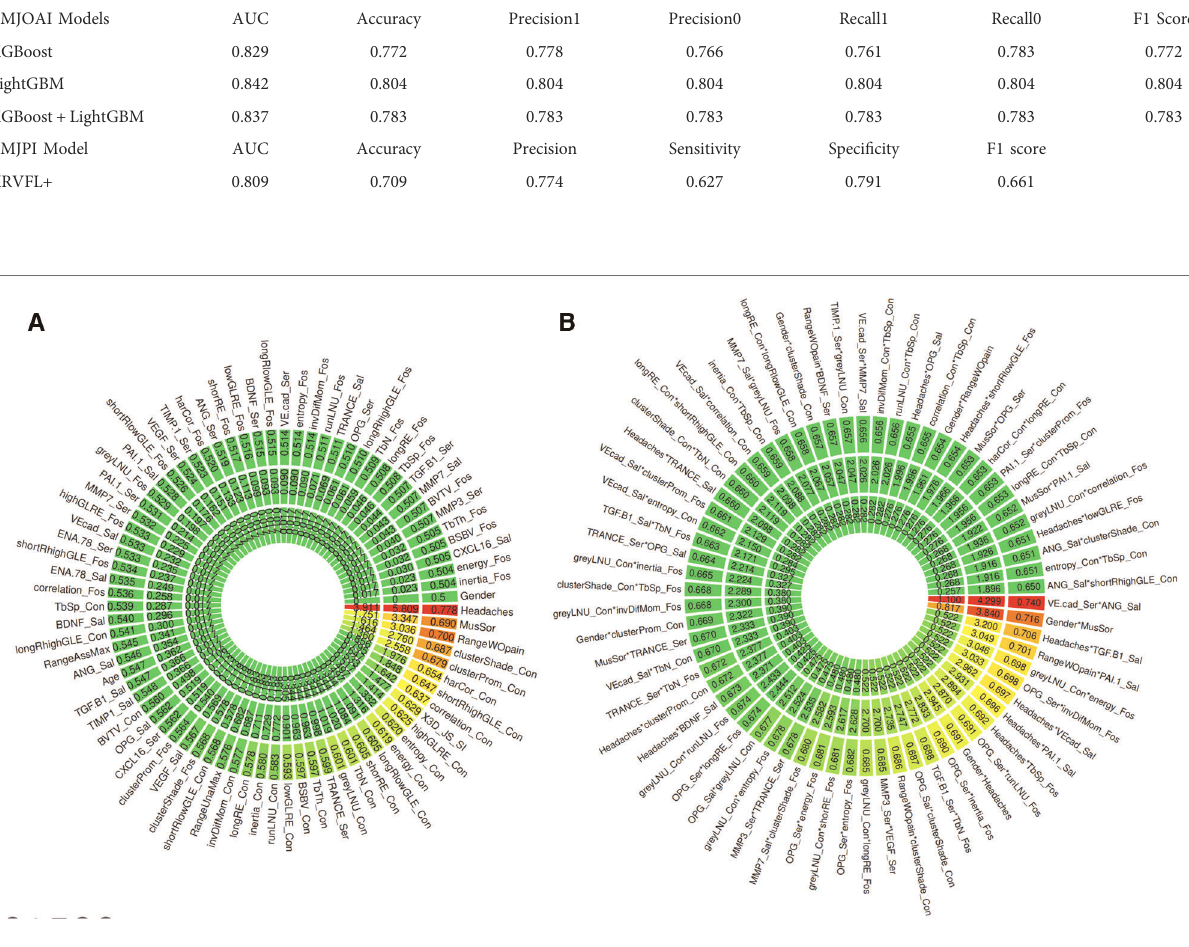
FIGURE 3 General association analysis of risk factors for 79 features ( A ) and 66 top interactions ( B ). ( A,B ) The outer circle shows the AUC, middle circle shows the p -values, and the inner circle shows the q-values for each single